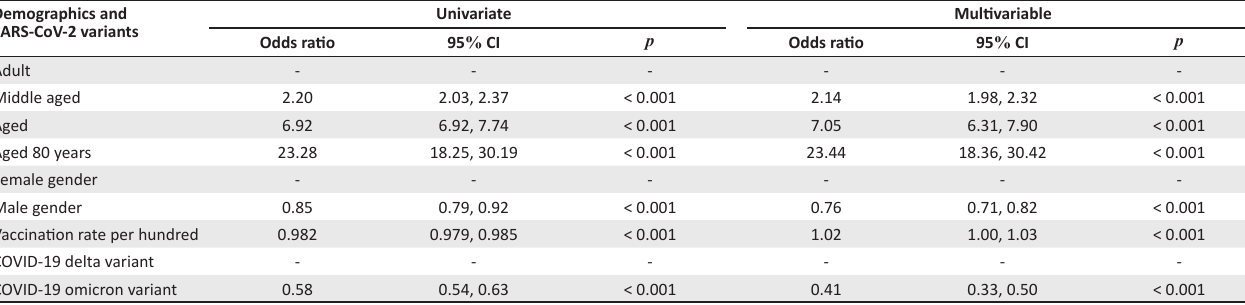
TABLE 4: Model odds ratios for elevated D-dimer test results. Demographics and SARS-CoV-2